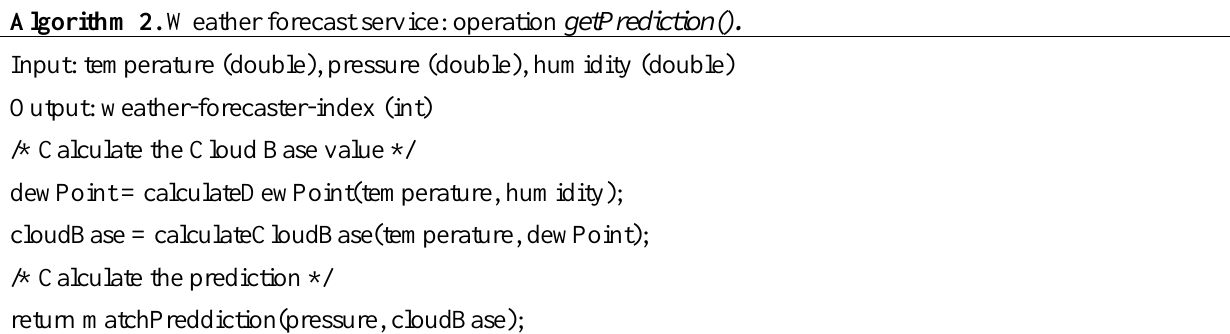
Algorithm 2. Weather forecast service: operation